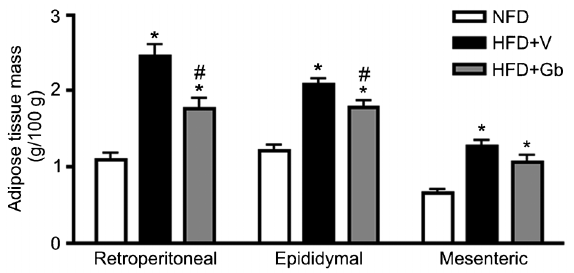
Figure 4. Mass weight (g) of retroperitoneal, epididymal and mesenteric white adipose tissue depots of normal fat diet (NFD; n=16), high-fat diet plus vehicle (HFD++V; n=11), and high-fat diet plus Ginkgo biloba (HFD++Gb; n=9) groups after phytother-